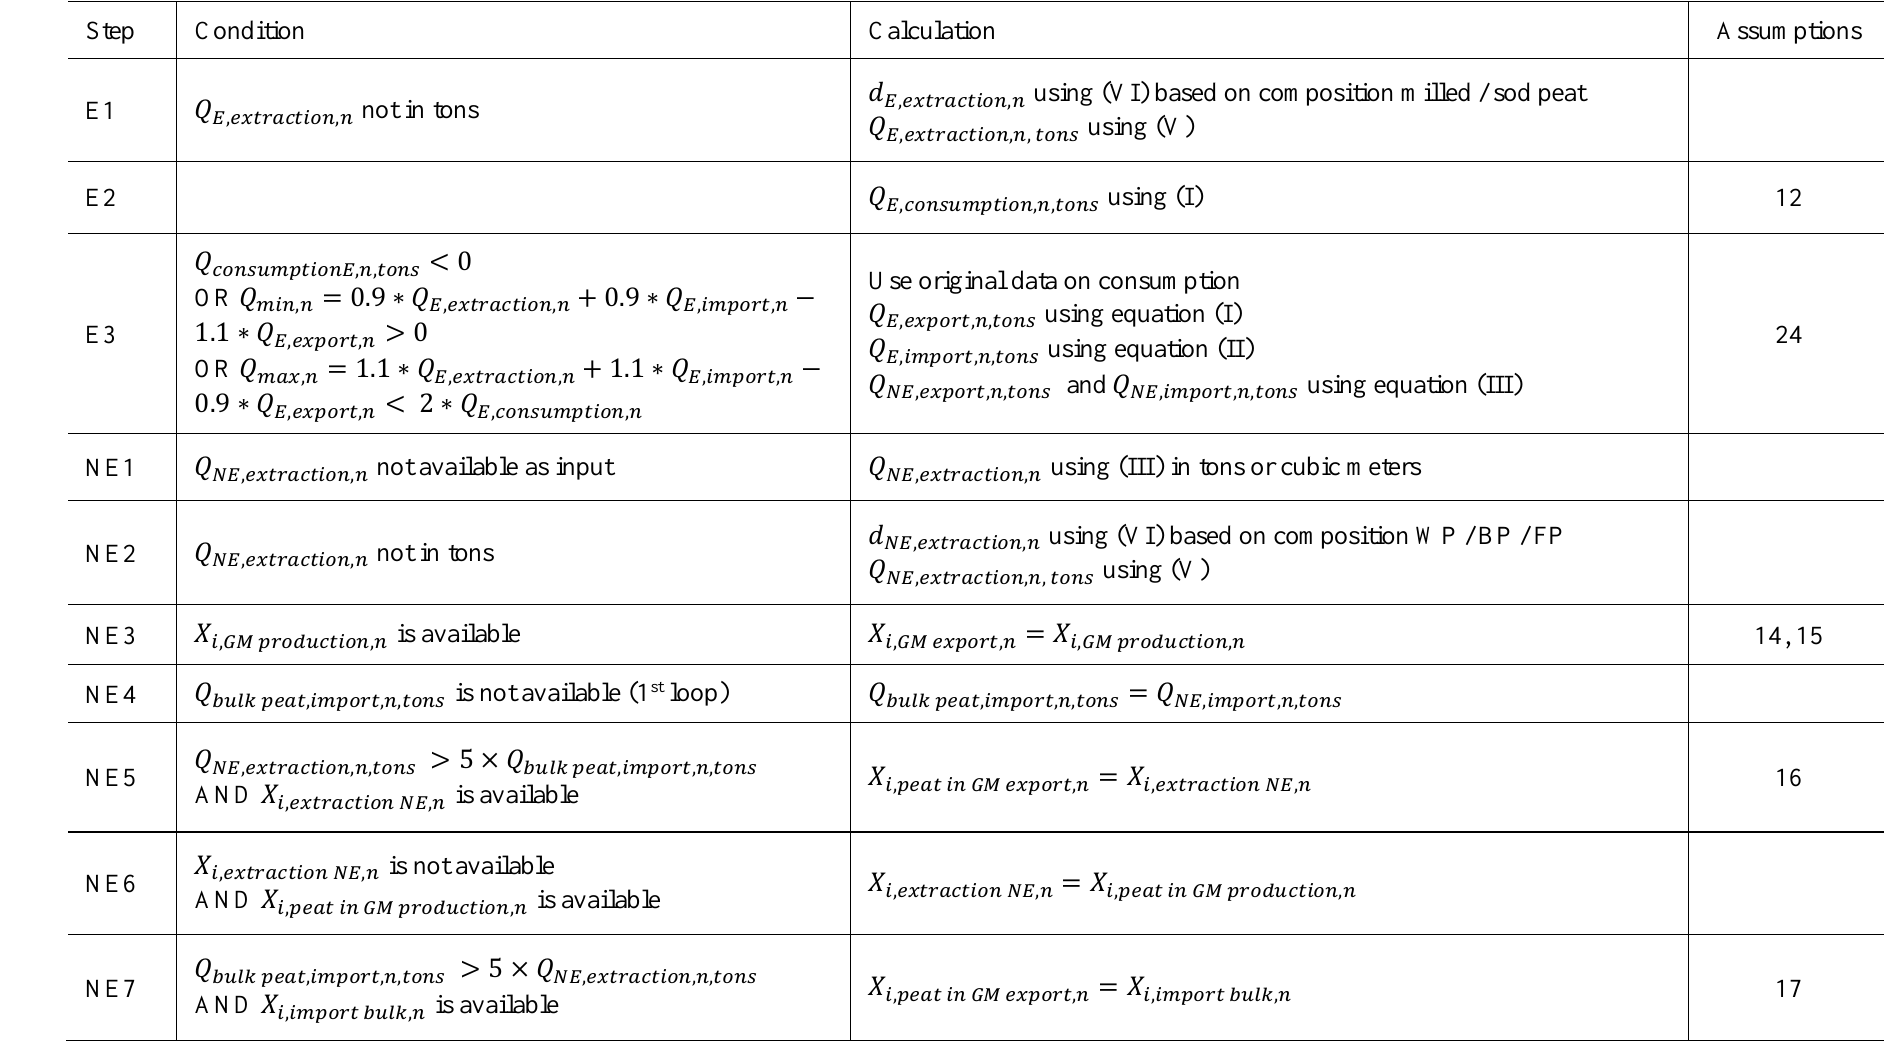
Table A7. Steps of the data combination, the identification of discrepancies and the data correction for energy (E) peat (E1 to E3) and non-energy (NE) peat (NE1 to